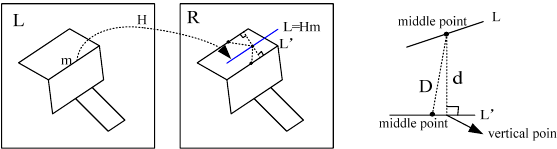
Figure 2. Constraint of candidate lines based on the modified homograph matrix Figure 3. Using epipolar constraint to find corresponding overlap segments for line matching